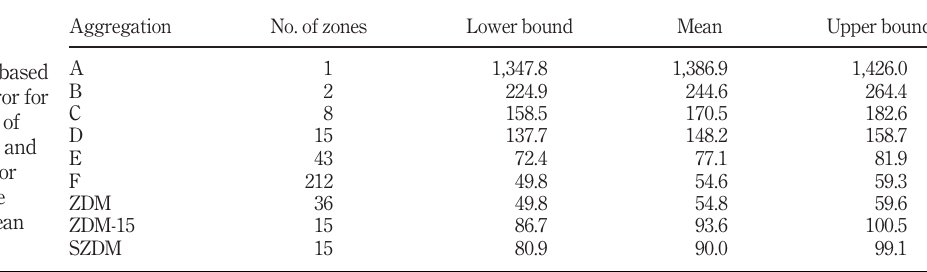
Table 1. Mean distance-based aggregation error for 10,000 samples of size 500. Lower and upper bounds for 95% con fi dence interval and mean are